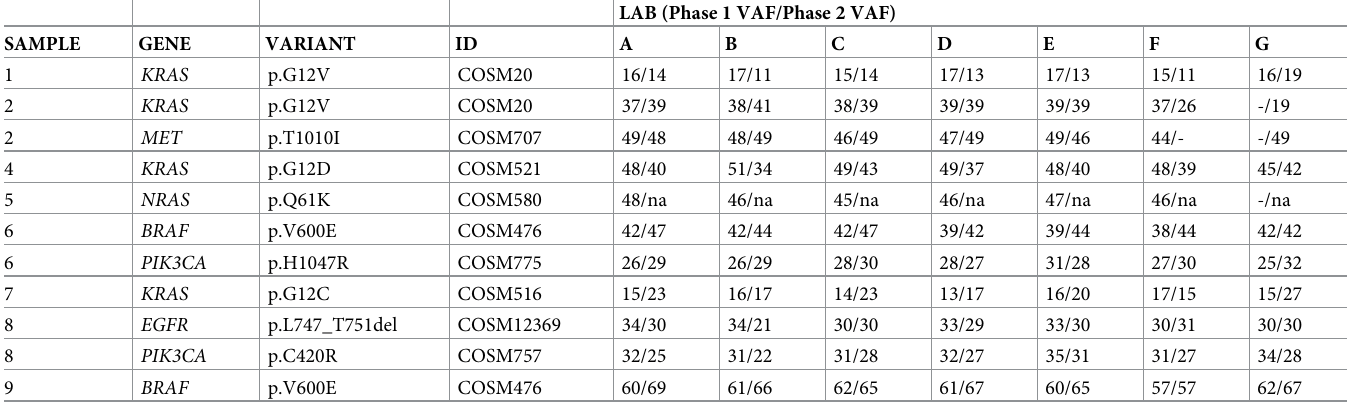
Table 14. Variant allele fractions for the gain of function variants detected by the ring study laboratories across Phase 1 and Phase 2 for the clinical specimens.